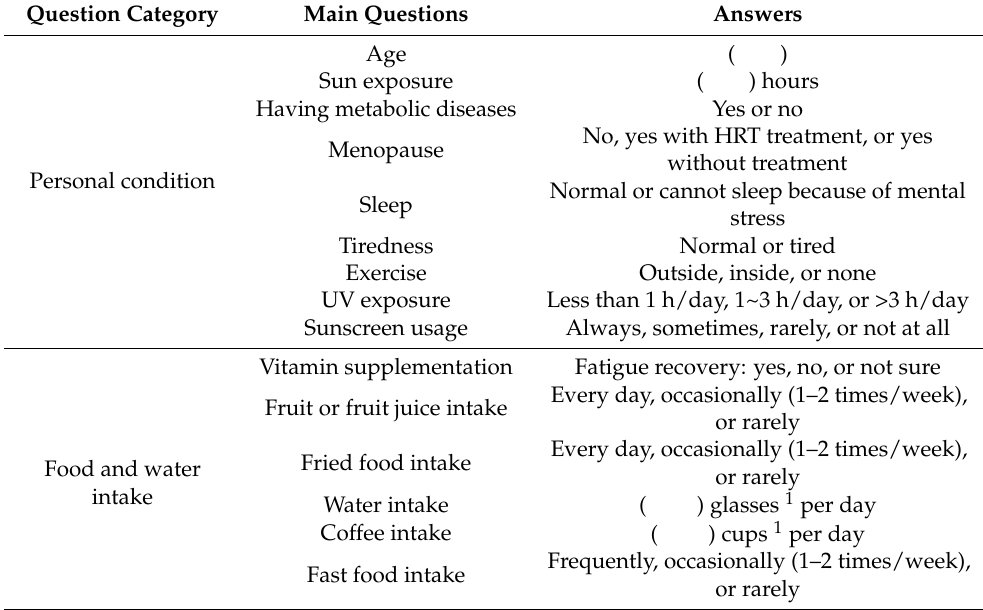
Table 1. Survey questionnaires influencing skin